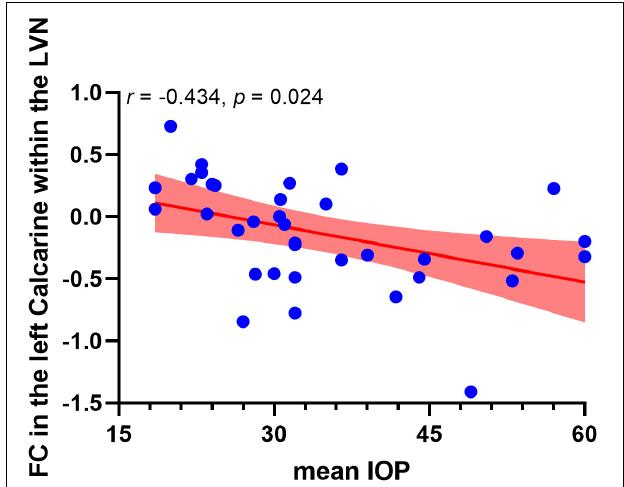
FIGURE 3 | Negative correlation between functional connectivity within the lateral visual network and occipitotemporal visual network and mean IOP in high-tension glaucoma brain. The red area indicates 95% confidence interval. LVN, lateral visual